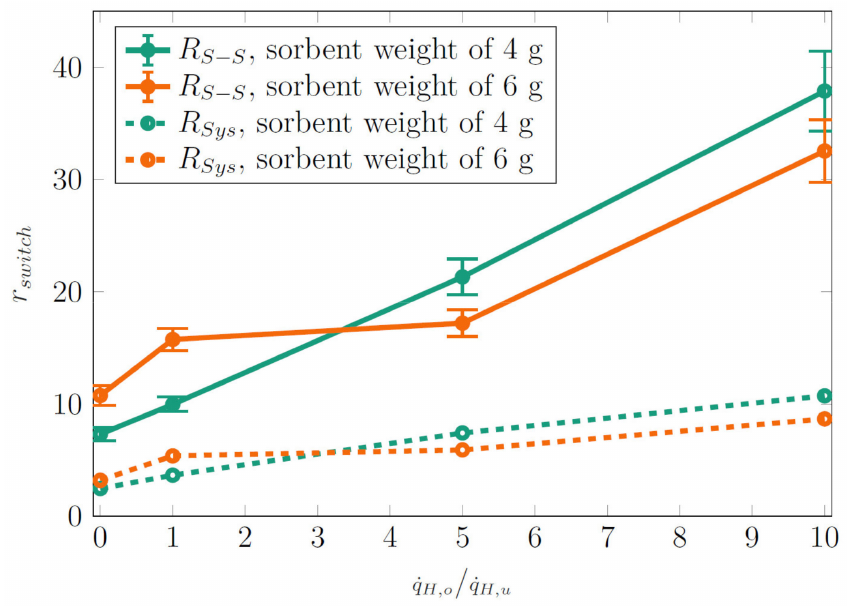
Figure 11. Switching ratio r switch calculated from R S − S (Figure 9) and R Sys for different heat power ratios and sorbent